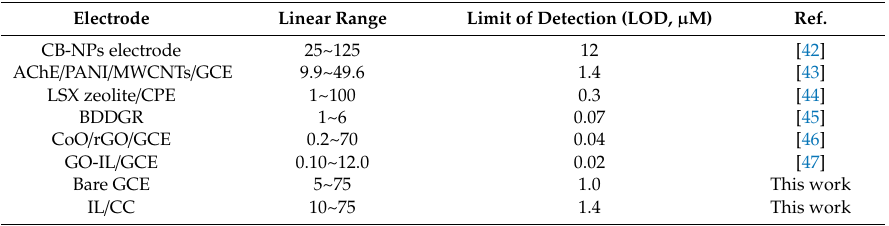
Figure 5. ( A ) SWV curves of 50 µ M CBL and 1 µ M NB at glassy carbon electrode (GCE) (a), carbon cloth (CC) (b), and IL / CC (c); ( B ) calibration curves of CBL using single-signal on IL / CC. ( C ) Calibration curves of CBL using dual-signal on IL / CC. Inset: SWV curves of various concentration of CBL. Error bars: standard deviation (SD); n = 3. Table 1. Comparison of analytical parameters on various electrodes. Electrode Linear Range Limit of Detection (LOD, µ M)